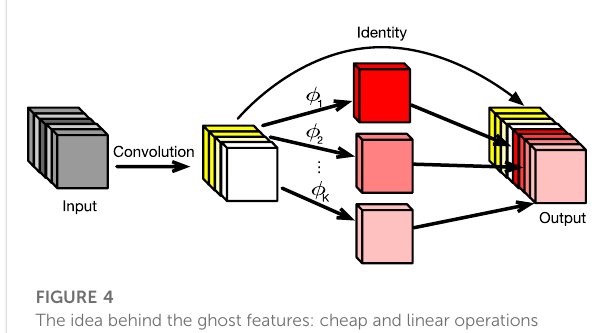
FIGURE 4 The idea behind the ghost features: cheap and linear operations generate redundant feature maps instead of convolutional